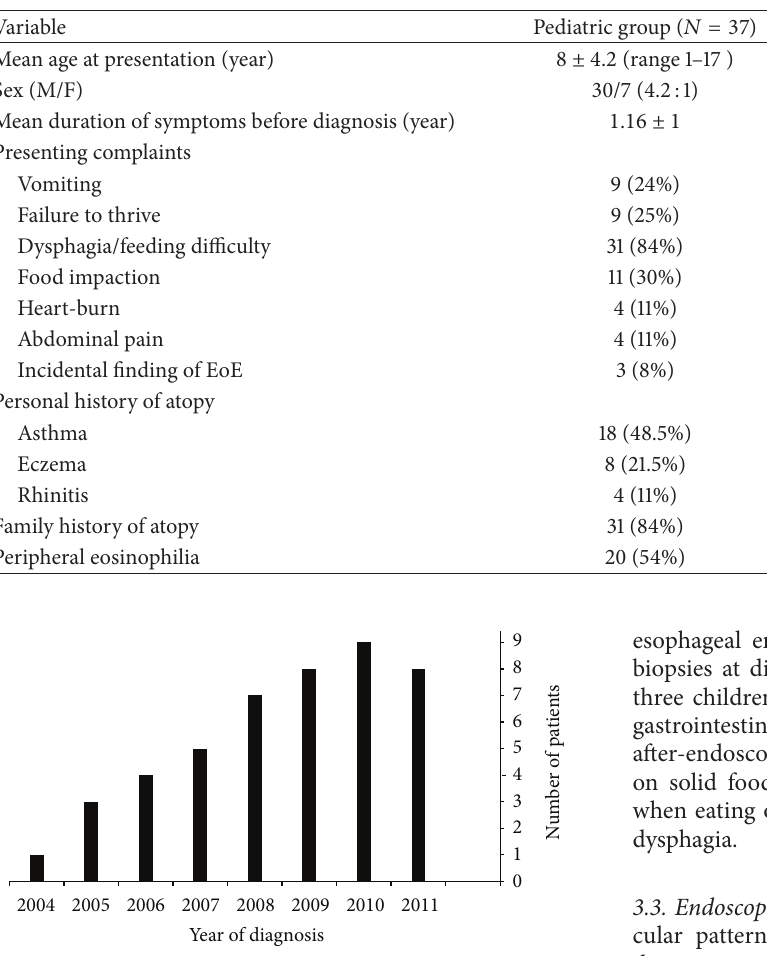
Figure 1: Distribution of eosinophilic esophagitis cases by year of